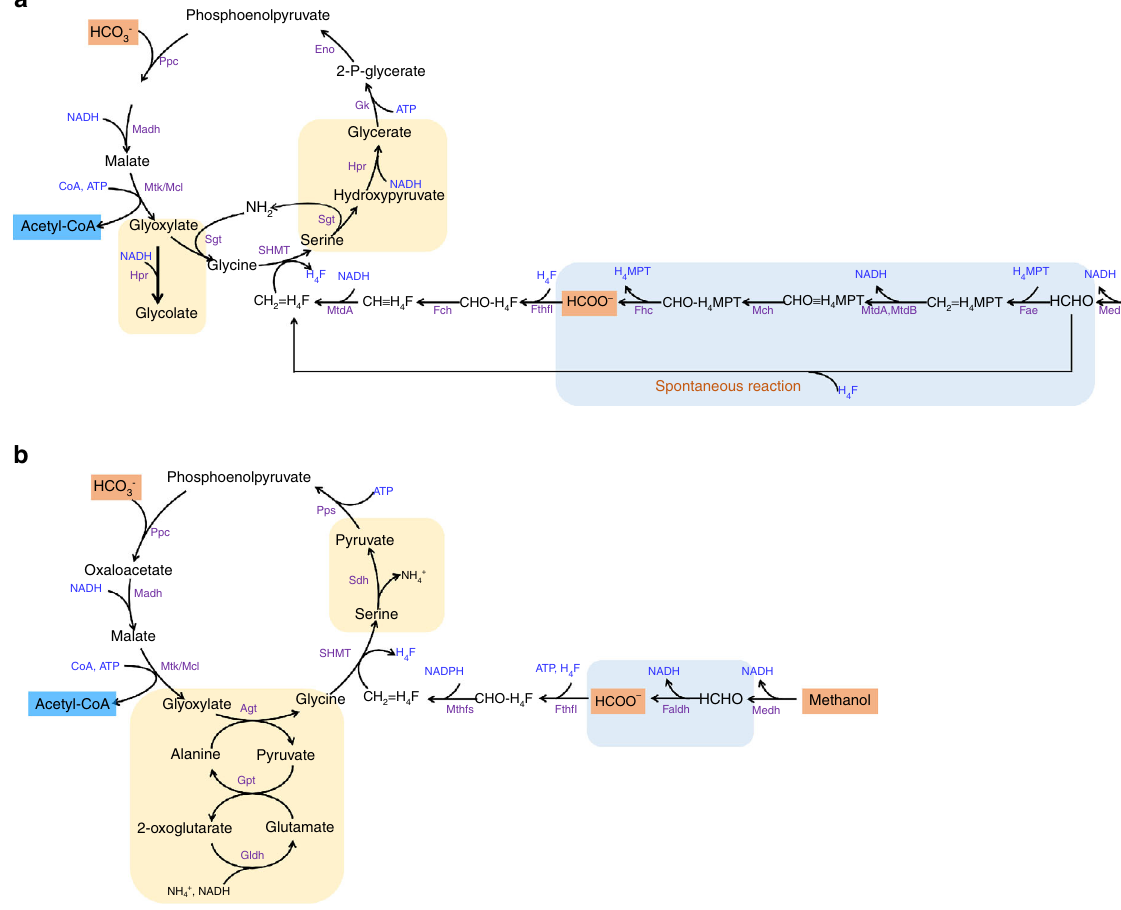
Fig. 1 Design of the modi fi ed serine cycle for E. coli . a Illustration of the natural serine cycle in Methylobacterium extorquens AM1 . b Illustration of the modi fi ed serine cycle for acetyl-CoA synthesis. Compared to the natural serine cycle ( a ), the modi fi ed serine cycle uses formaldehyde dehydrogenase (Faldh) to simplify the oxidation of formaldehyde to formate (blue box), and also utilizes the Agt Sdh combination to avoid hydroxypyruvate as an intermediate in the conversion from glyoxylate to PEP (yellow box). CH 2 = H 4 F 5,10-methylene-H 4 F, Ppc phosphoenolpyruvate carboxylase, Madh malate dehydrogenase, Mtk malate thiokinase, Mcl malyl-CoA lyase, Agt alanine-glyoxylate transaminase, SHMT serine hydroxymethyltransferase, Sdh serine dehydratase, Pps phosphoenolpyruvate synthase, Fth fl formate THF ligase, Mthfs 5,10-methylene-tetrahydrofolate synthase (C1-THF synthase), Medh methanol dehydrogenase, Faldh formaldehyde dehydrogenase, Gpt glutamate-pyruvate transaminase, Gldh glutamate dehydrogenase, Sgt serine- glyoxylate transaminase, Hpr hydroxypyruvate reductase, Gk glycerate kinase, Eno enolase, Fae formaldehyde-activating enzyme, Mtd NADP-dependent methylene-tetrahydromethanopterin/methylene-tetrahydrofolate dehydrogenase, Mch N (5), N (10)-methenyltetrahydromethanopterin cyclohydrolase, Fhc formyltransferase/hydrolase complex, Fch methenyltetrahydrofolate